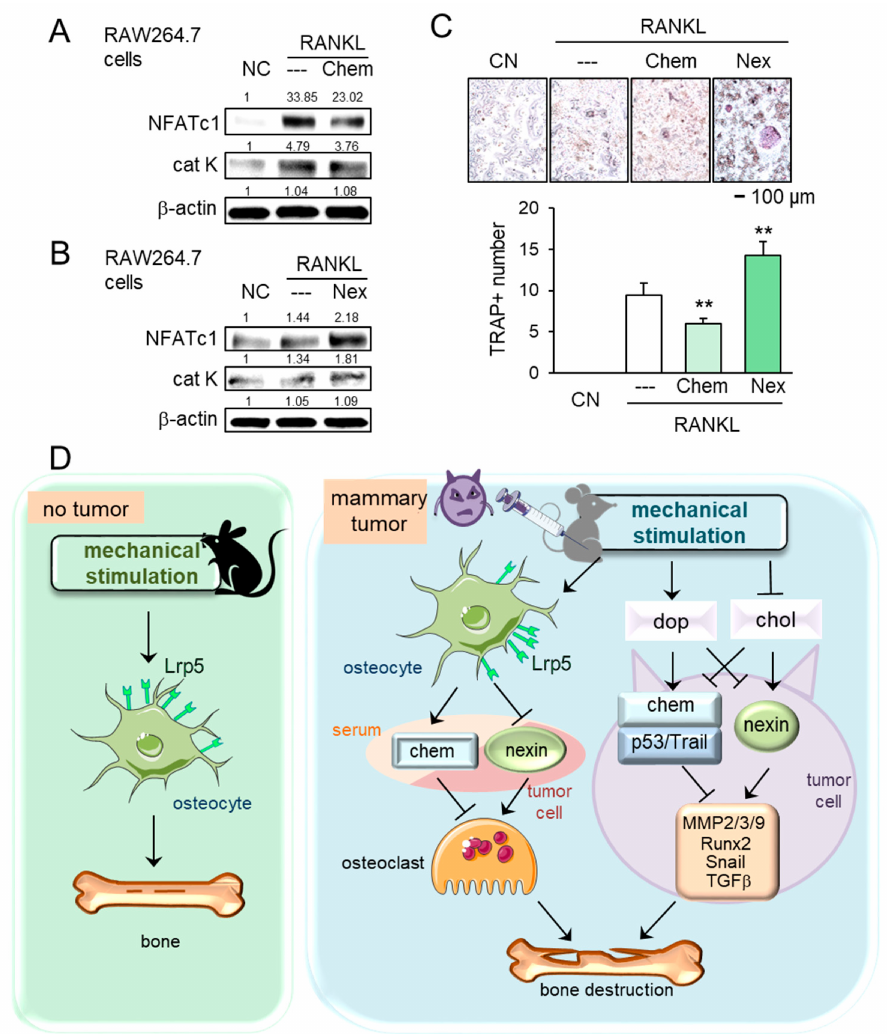
Figure 7. Effects of chemerin and nexin on osteoclasts, and the proposed regulatory mechanism. The double asterisk indicates p < 0.01. ( A , B ) Downregulation of NFATc1 and cathepsin K by chemerin and their upregulation by nexin in RANKL-stimulated RAW264.7 osteoclasts. ( C ) Reduction and elevation of tartrate-resistant acid phosphate (TRAP)-positive cells by chemerin and nexin, respectively. ( D ) Proposed regulatory mechanism for female mice in response to knee loading. Without tumor inoculation, Lrp5 in osteocytes is necessary to induce loading-driven bone formation. In the tumor- invaded tibia, mechanical loading suppresses bone destruction regardless of Lrp5 in osteocytes. The beneficial loading effects are mediated by the elevation of dopamine and the reduction in